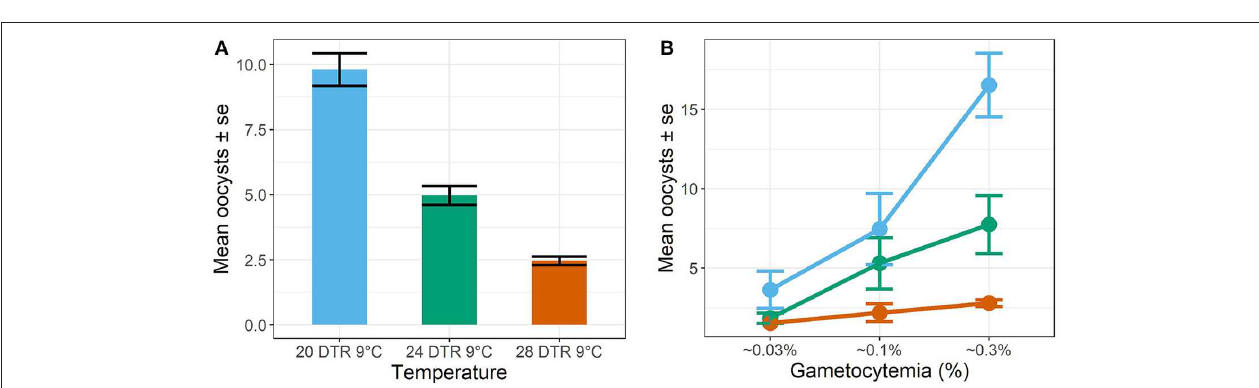
FIGURE 4 | Oocyst intensities (midguts with oocysts ≥ 1, i.e., infected midguts) across temperatures (A) and gametocyte density (B) . Values represents means ± standard error (se) from three biological replicates.